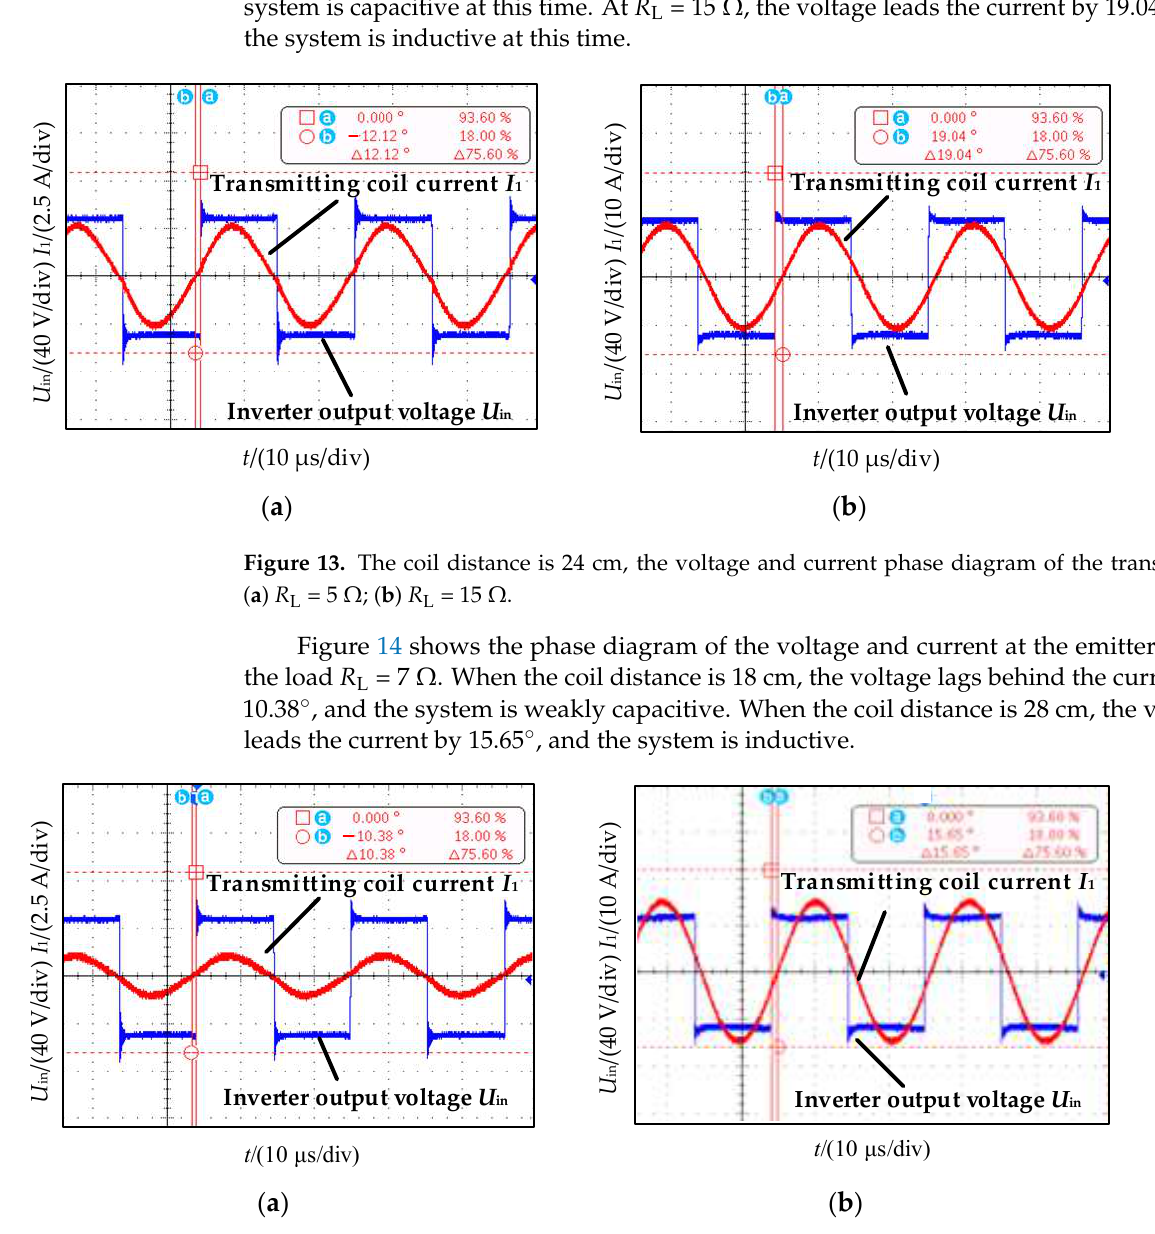
Figure 14. R L = 7 Ω, voltage and current phase diagram of transmitter: ( a ) coil distance of 18 cm; ( b ) coil distance of 28 cm.